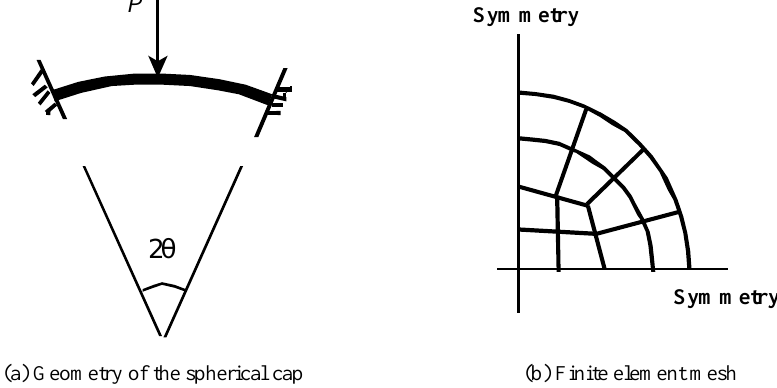
Fig. 4. Geometry of the spherical shell and its finite element mesh.